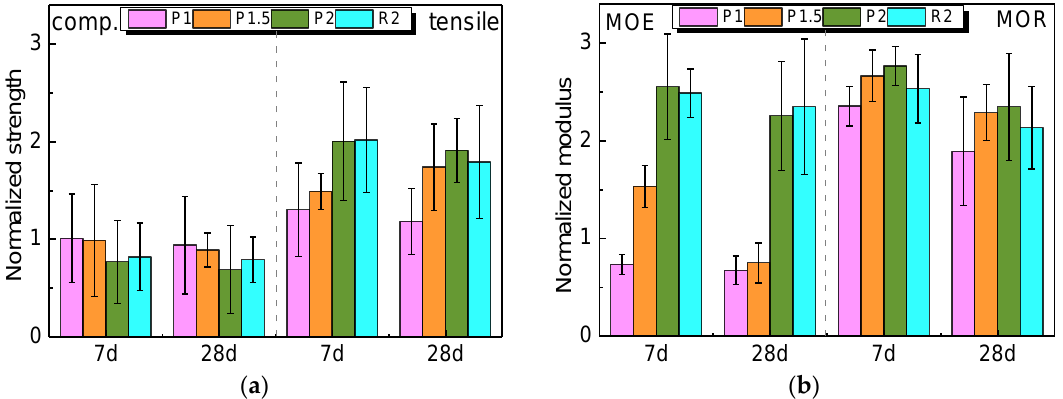
Figure 7. Normalized compressive strength, tensile strength, modulus of elasticity (MOE), and modulus of rupture (MOR) of NPFRCCs at seven days and 28 days.